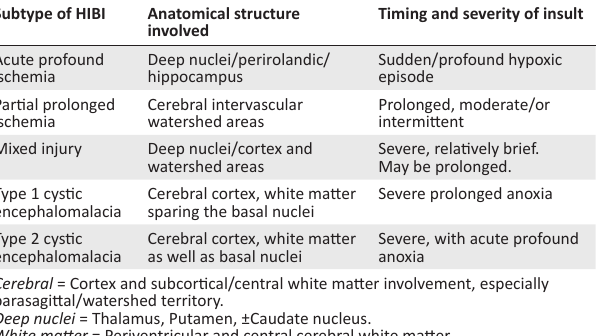
TABLE 1: The basic patterns of magnetic resonance imaging abnormalities in hypoxic ischemic encephalopathy. Subtype of HIBI